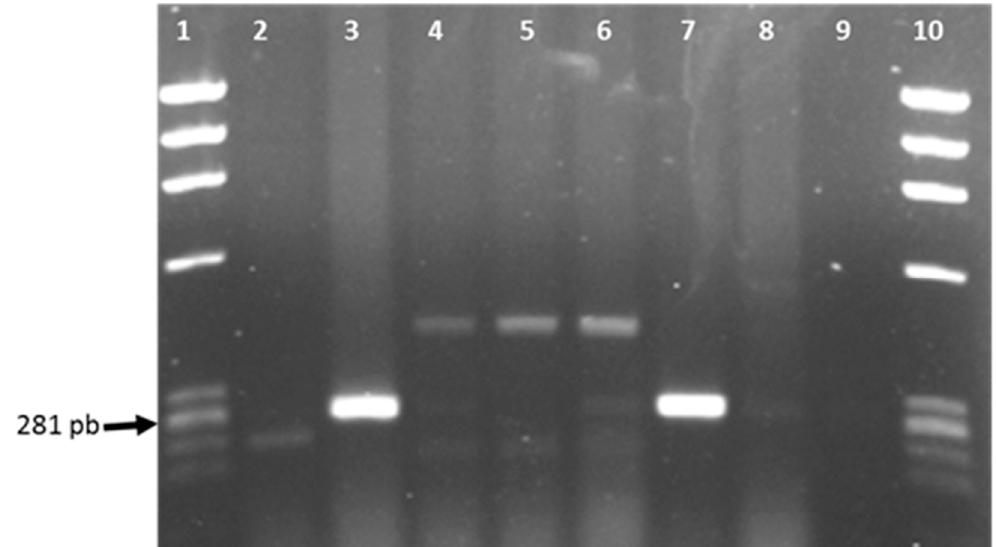
Figure 3. PCR amplification products with Sal 3 and Sal 4 of cell lysates. Lanes: 1 and 10, Marker DNA/Hae; Lanes 2, 4 and 5, strains of indeterminate species of C. youngae and C. freundii ; Lane 3, strain of S . Javiana; Lane 6, strain of C. freundii ; Lane 7, S. Typhimurium ATCC23564; Lane 8, E. coli 042; Lane 9, water.